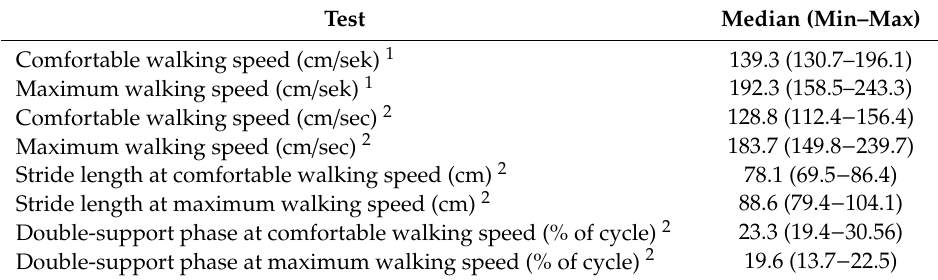
Table 2. Relevant gait parameters of the subjects